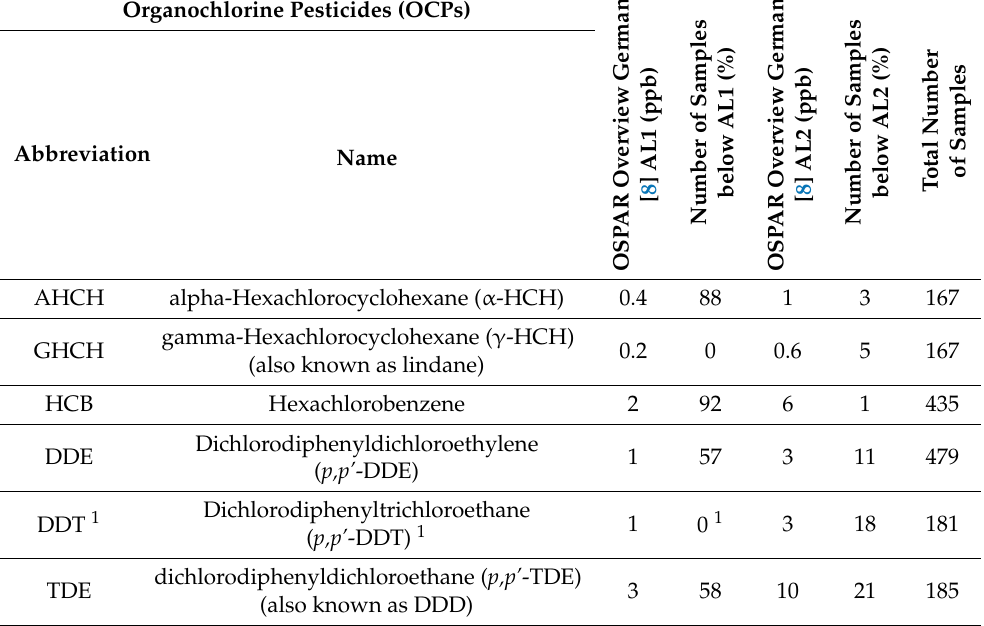
Table 18. Organochlorine pesticides (OCPs)—Individual OCPs—OSPAR overview German— Percentage of samples below AL1; above AL2; and range. No data and no AL1 or AL2 are available for beta-Hexachlorocyclohexane ( β -HCH) (BHCH); and no AL1 or AL2 are available for Dieldren (OSPAR overview German